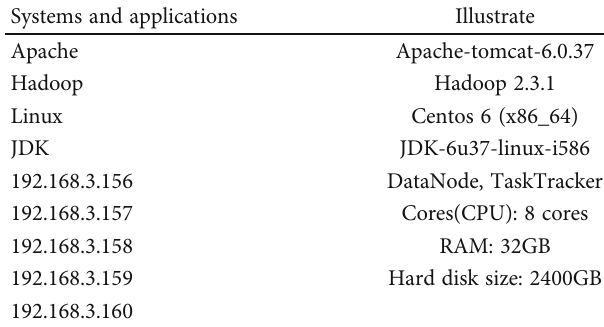
Table 5: Distributed cluster environment. Systems and applications